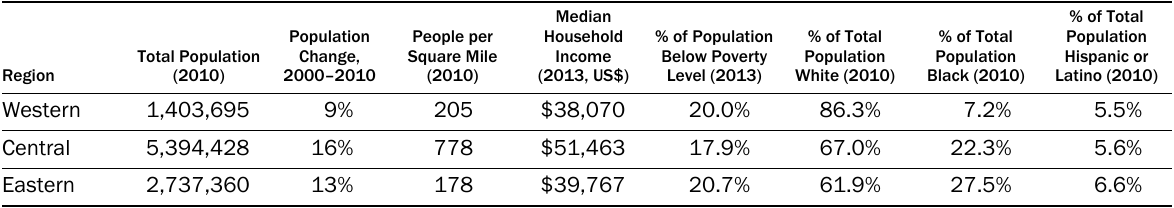
Table 1. North Carolina Regional Characteristics